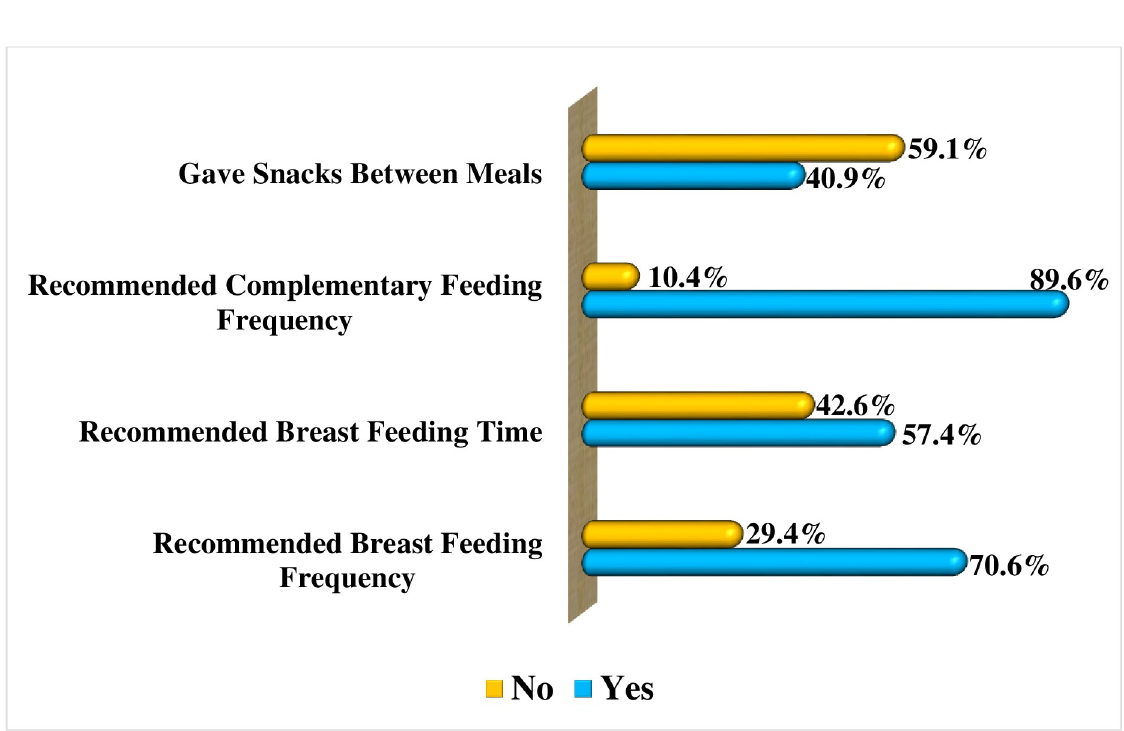
Fig 6. Caregivers’ dietary adequacy feeding practices based on the WHO recommended Minimum Meal Frequency (MMF). Source : Field Data (2022).